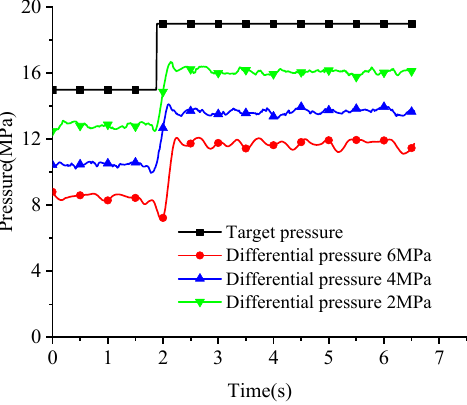
Figure 24. Variation curve of the outlet pressure under different pressure differences. The pressure curve when the system flow changes is given in Figure 25. The inlet target pressure of the relief valve is 18.5 MPa, and the pressure difference of valve port is 4 MPa. When the flow rate changes, due to the influence of the pressure regulating characteristics of the relief valve, the inlet pressure of the relief valve slightly decreases, but it is basically not affected by the flow rate change.